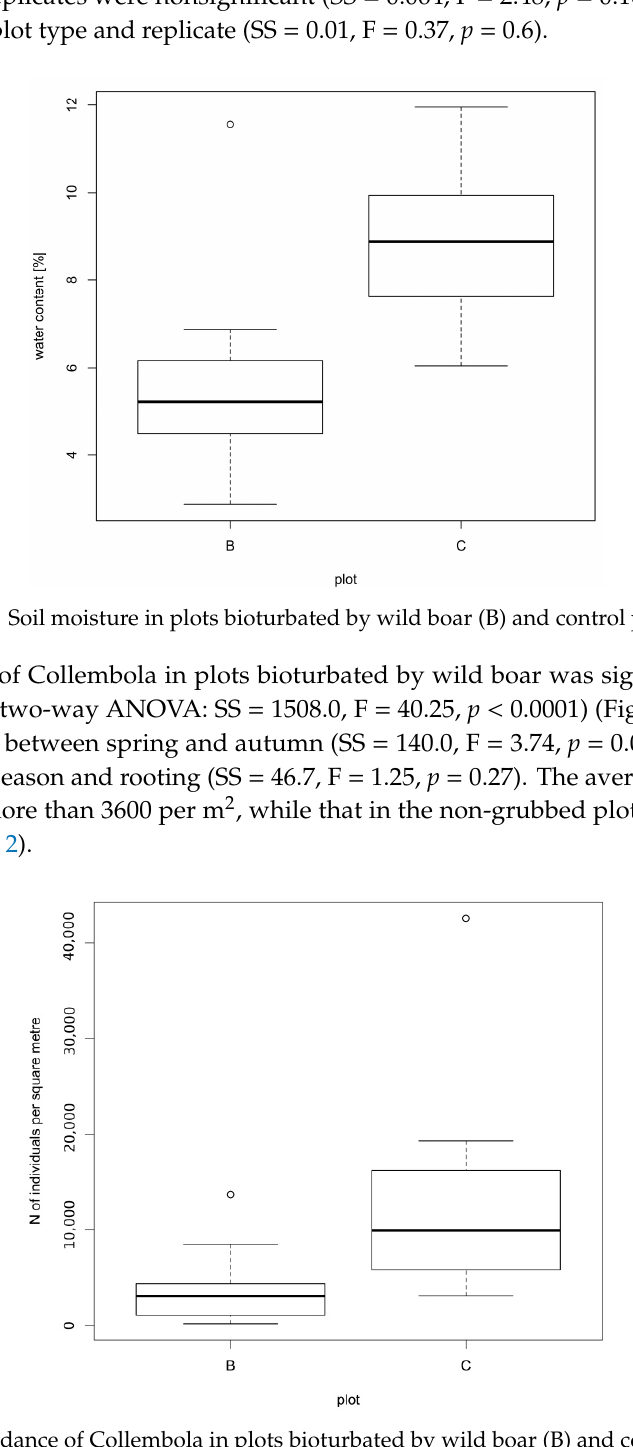
Figure 2. Abundance of Collembola in plots bioturbated by wild boar (B) and control plots (C).